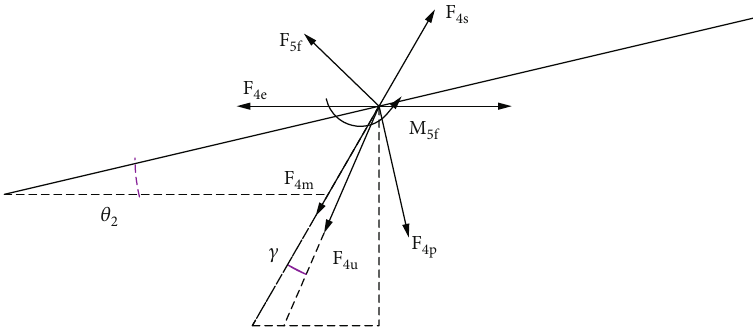
Figure 5: Force analysis of the second joint of the